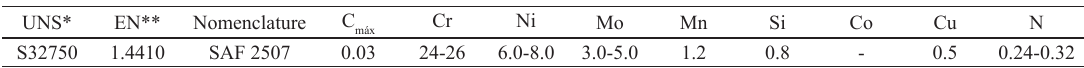
Table 1. Chemical composition of SAF 2507 – SDSS (%) (data provided by the manufacturer “Sandvik